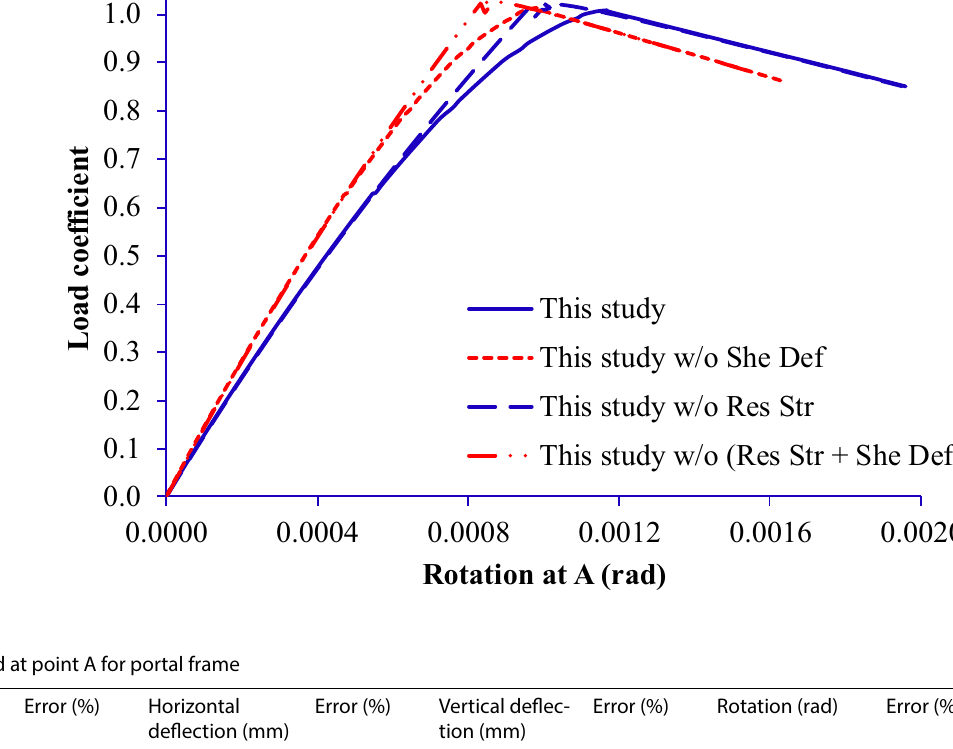
Table 1 Deflection at limit load at point A for portal frame